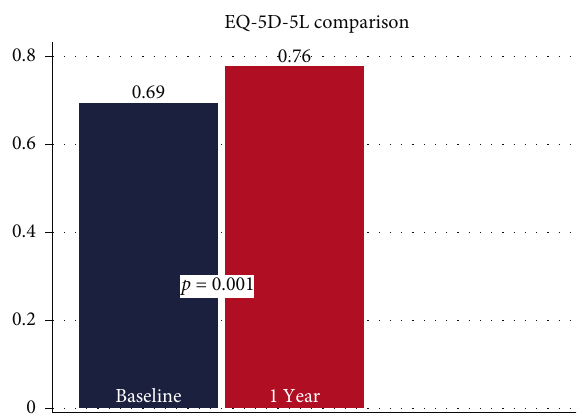
Figure 4: Bar graph comparing mean EQ-5D-5L scores at baseline and 1 year. Table 5: Clinically important 1-year results.